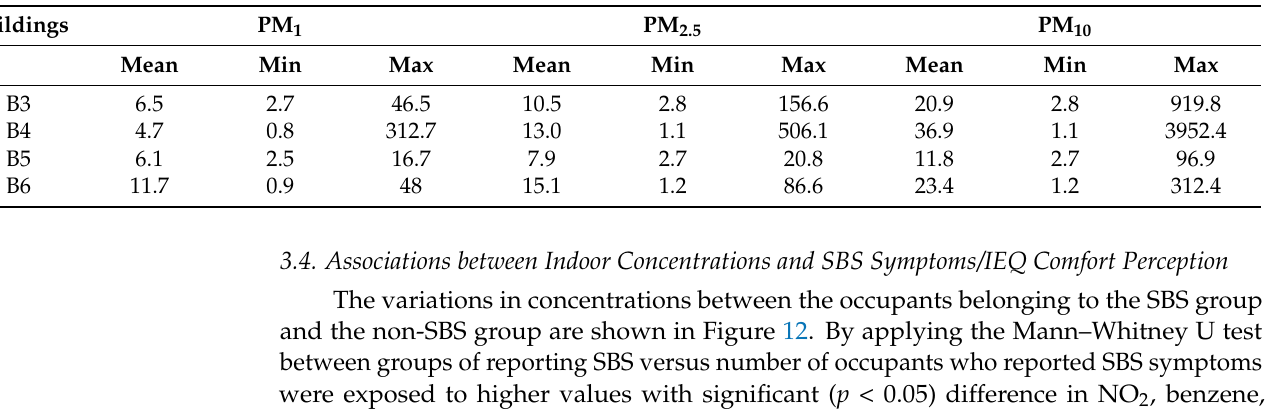
Table 4. PM indoor concentrations.